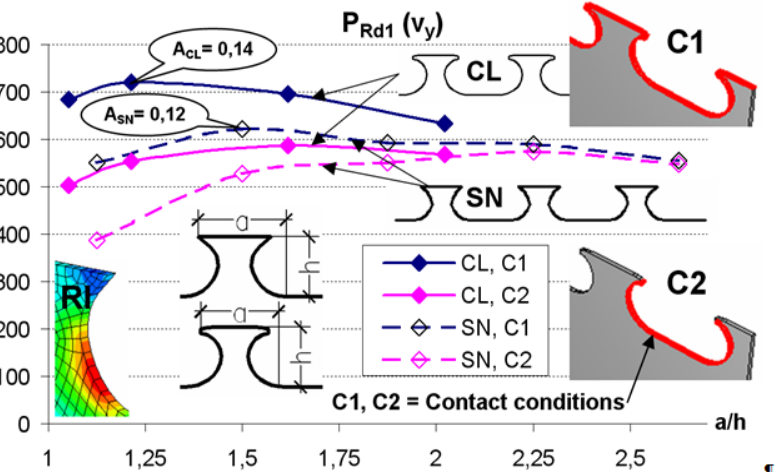
Figure 30: Results of the optimization of the CL shape versus the SN shape, presenting the force per unit length versus shape ratio (1D1 model, linear concrete material and linear steel material; RI represents reduced integration in finite elements [1] and C1 and C2 represent different contact interactions).